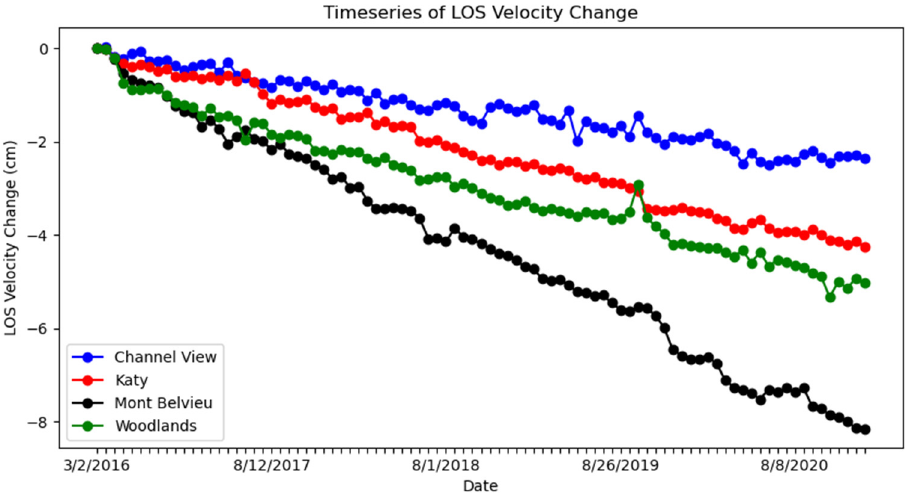
Figure 8. LOS displacement time series for areas with high subsidence rates. Data derived from the InSAR analysis from 2016 to 2020. InSAR analysis from 2016 to